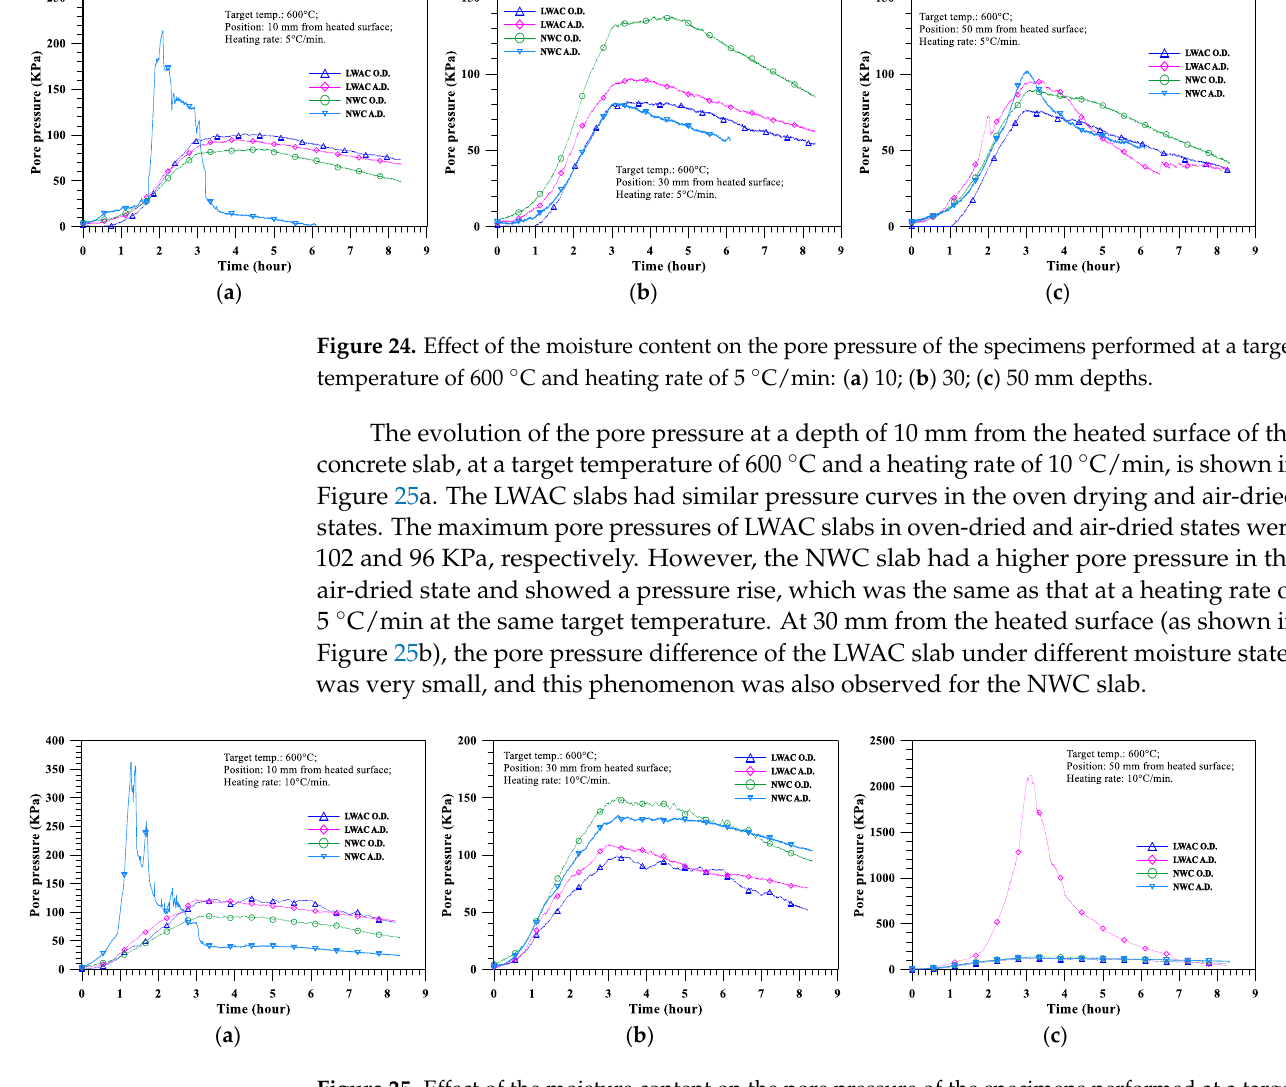
Figure 25. Effect of the moisture content on the pore pressure of the specimens performed at a target temperature of 600 °C and heating rate of 10 °C/min: ( a ) 10; ( b ) 30; ( c ) 50 mm depth.